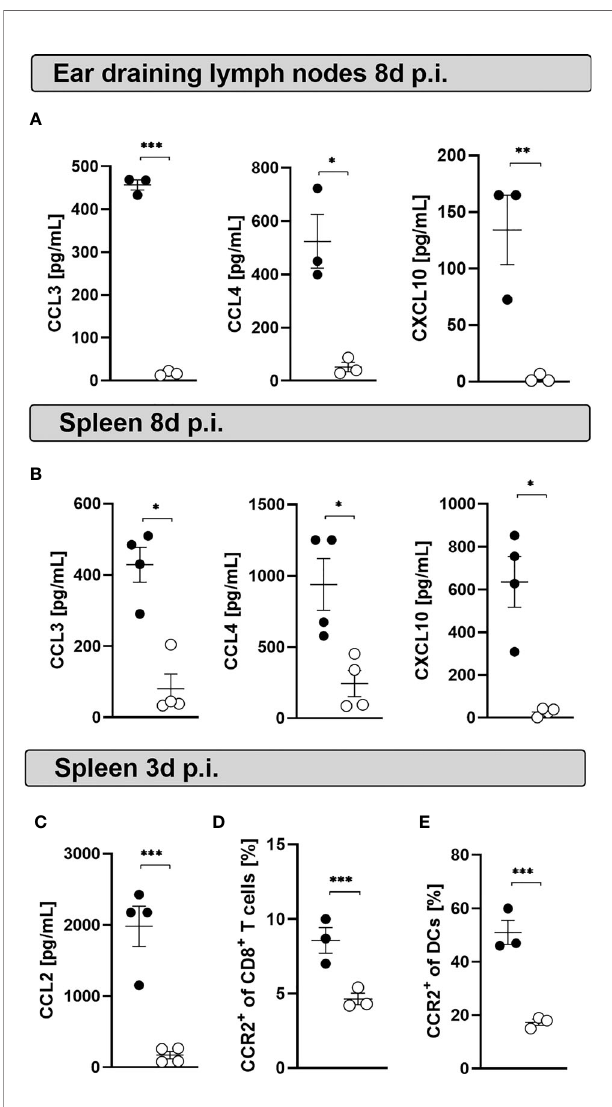
FIGURE 5 | Mast cell de fi cient mice display decreased chemokine levels at the peak of the infection. Concentrations of CCL3, CCL4 and CXCL10 in the supernatants of cultured cells from (A) ear-dLNs and from the (B) spleen of WT and MasTRECK mice at day 8 post infection. (C) Concentrations of CCL2 in supernatants of cultured splenocytes of WT and MasTRECK mice at day 3 post infection assessed by the chemokine 26-Plex Mouse ProcartaPlex ™ Panel 1. (D) Frequencies of CCR2 + CD8 + T cells and (E) CCR2 + DCs in the spleen of WT and MasTRECK mice at day 3 post infection analyzed by fl ow cytometry. All experiments were performed at least twice, and each experimental group included n ≥ 3. Data are representative and expressed as mean ± SEM. Statistically signi fi cant differences are analyzed by t- test and indicated as follows: *p < 0.05, **p < 0.01, ***p <